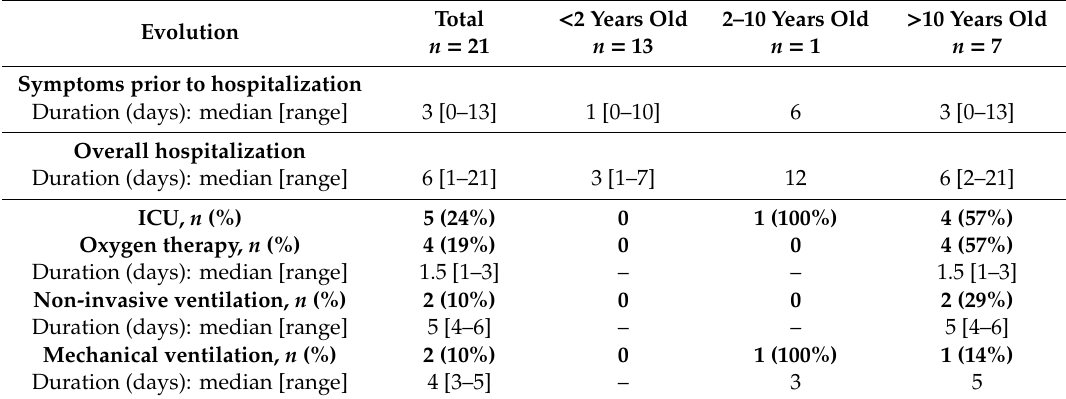
Abbreviations: ICU: intensive care unit. Sub-section headings are indicated in